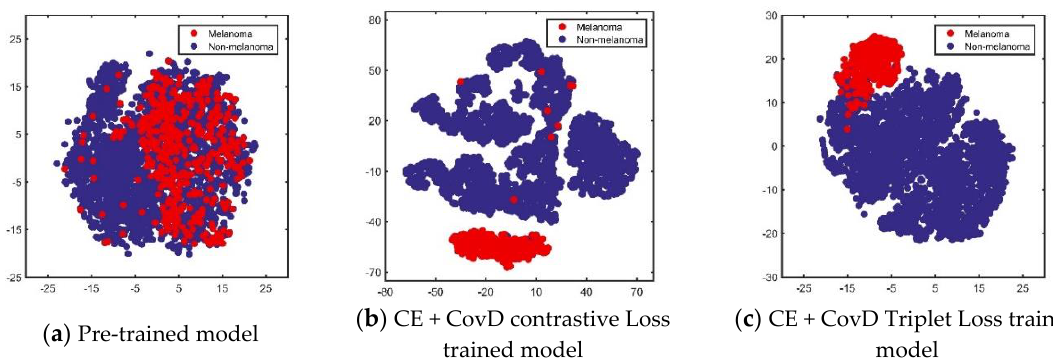
Figure 5. Feature visualization by t-Distributed Stochastic Neighbor Embedding